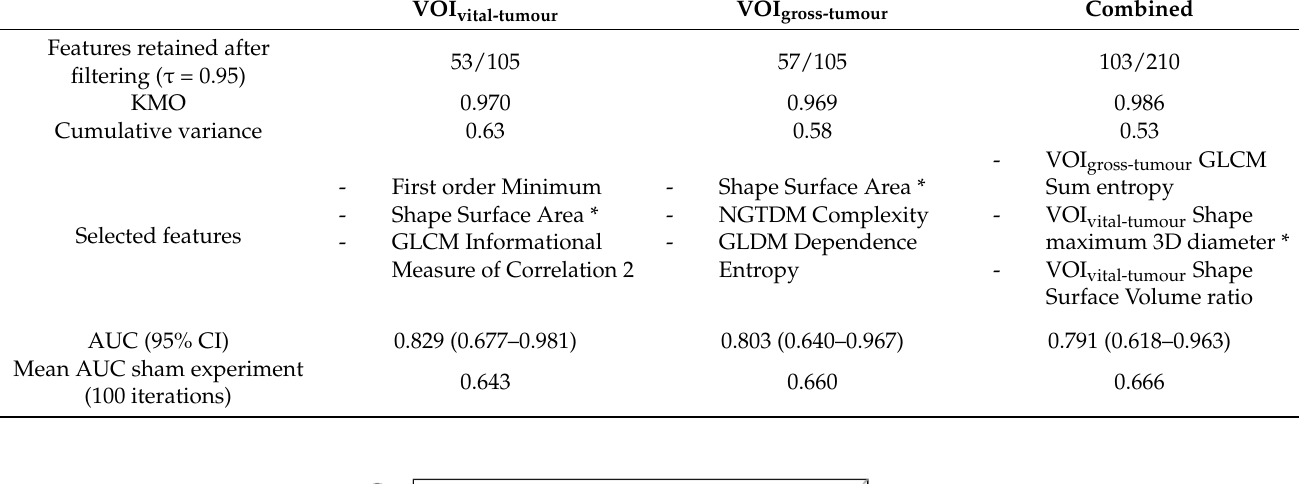
Table 5. Results of dimension reduction and predictive performance of the VOI vital-tumour , VOI gross-tumour and combined model for the noradrenergic biochemical profile in the PPGL cohort. For each model, 3 features were selected corresponding to the factors with the highest loadings. AUCs of the radiomic models and the mean AUC of the sham experiment are reported. Features marked with * are not significantly different between delineation methods in the PPGL dataset. KMO: